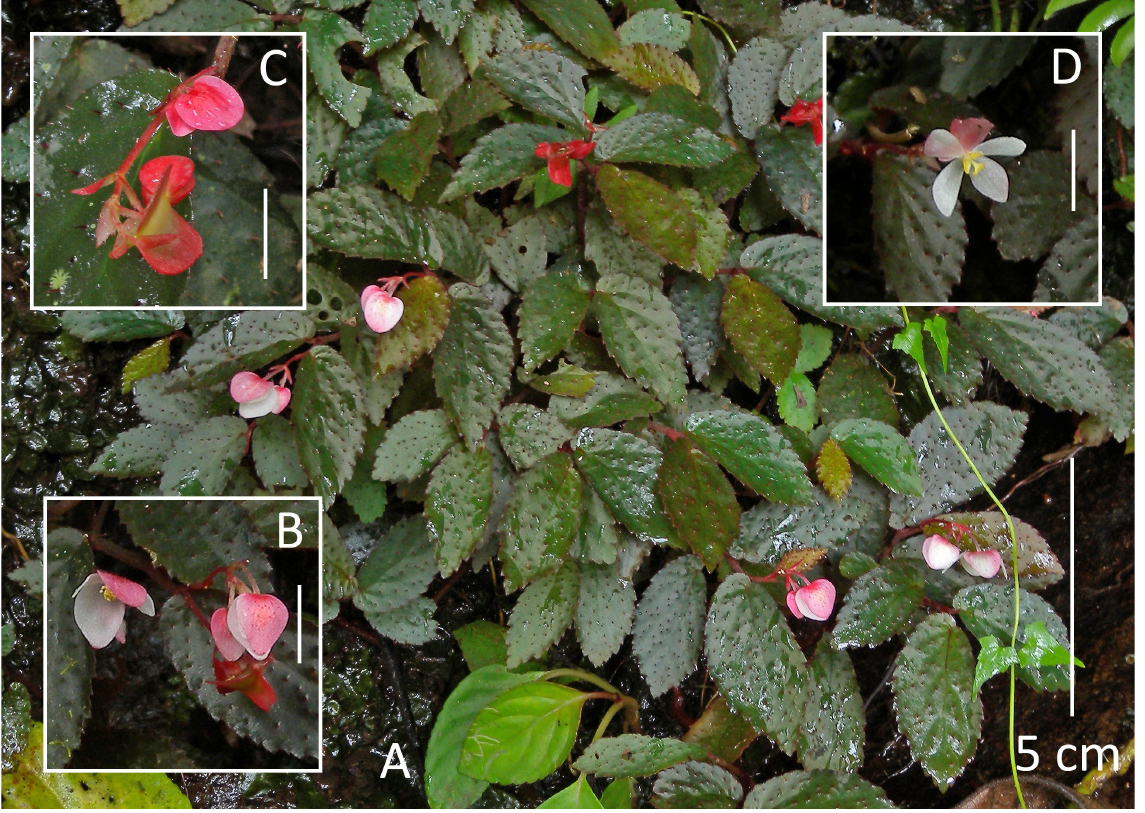
Fig. 7. Begonia jackiana M.Hughes sp. nov. A . Habit. B . Male flowers. C . Inflorescence with female flower recurved after pollination. D . Female flower. All photographs from Kapahiang, of the type Girmansyah & Hughes DEDEN1494 . Scale bars on insets = 1